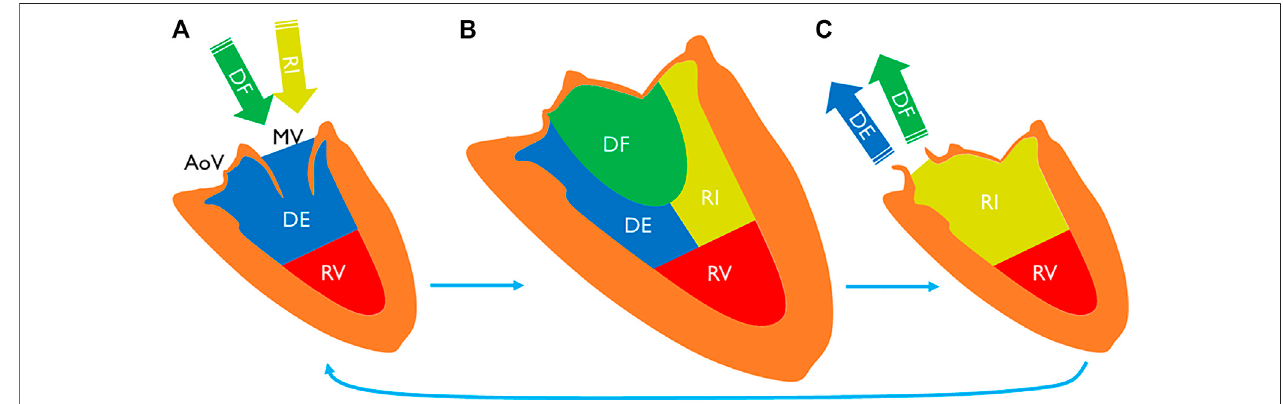
FIGURE 1 | LV blood volume (A) at the beginning of diastole, (B) at the end-diastole, and (C) at the end-systole. End-diastolic volume can be separated into four components.Direct fl owisapartofin fl owduringdiastole (A to B) ,exitingthechamberduringsystole (B to C) .Retainedin fl owisanotherpartthatremainsinthechamber at the end-systole (C) . Delayed ejection is a part of LV volume at the beginning of diastole (A) that exits during the cycle. Residual volume stays in the chamber for more than one cycle. MV indicates mitral valve; AoV, aortic valve; DF, direct fl ow; RI, retained in fl ow; DE, delayed ejection; and RV, residual